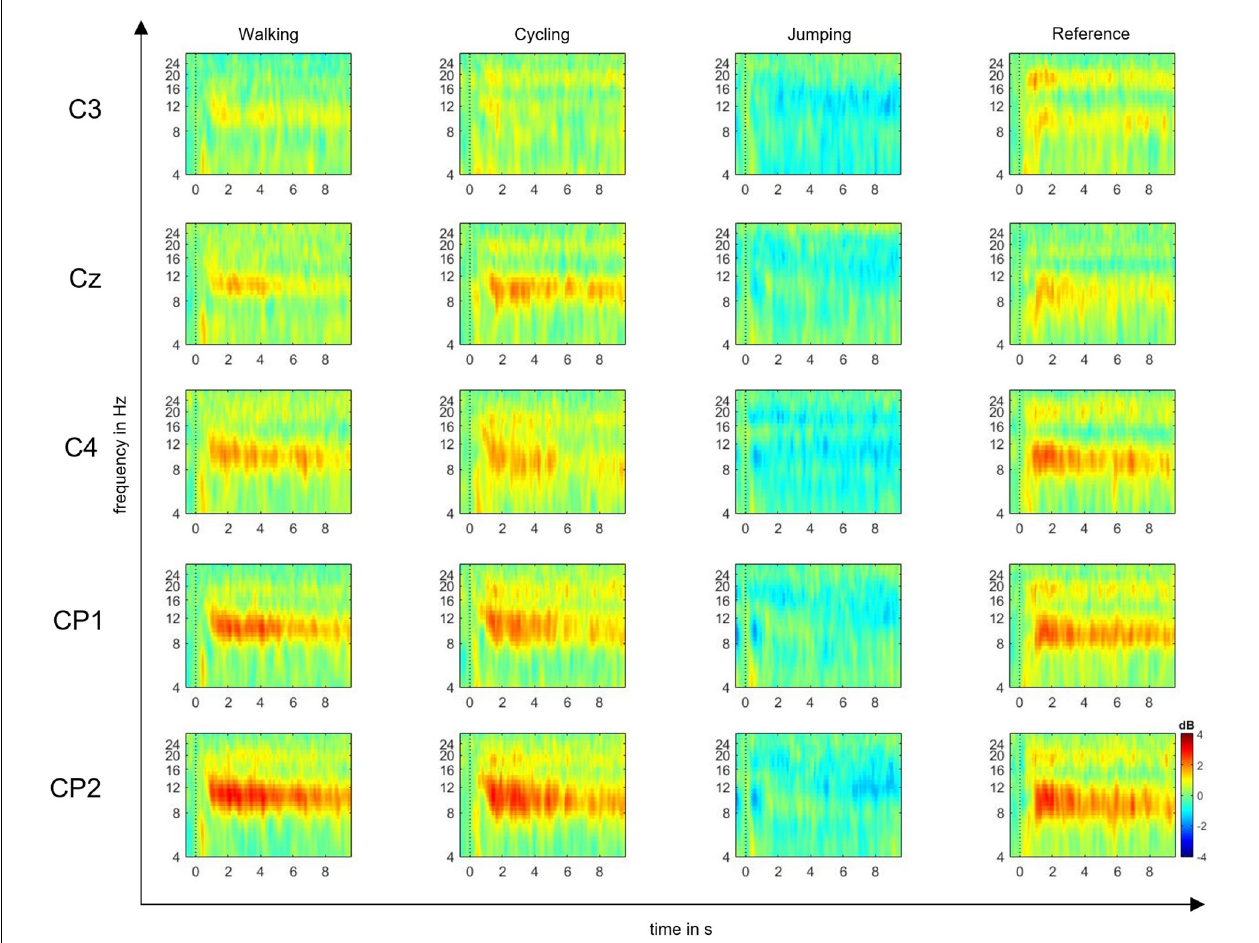
FIGURE 2 | Event-related spectral perturbation (ERSP) plots. ERSP plots show mean changes in spectral power during the motor imagery (MI) epoch, relative to a –200-ms pre-stimulus baseline. Plots are shown for the electrode positions C3, Cz, C4, CP1, and CP2, and the four experimental conditions: MI of walking, cycling, jumping, and reference. The red color represents the ERS, whereas the blue color represents the ERD in decibel (dB) (range: ±